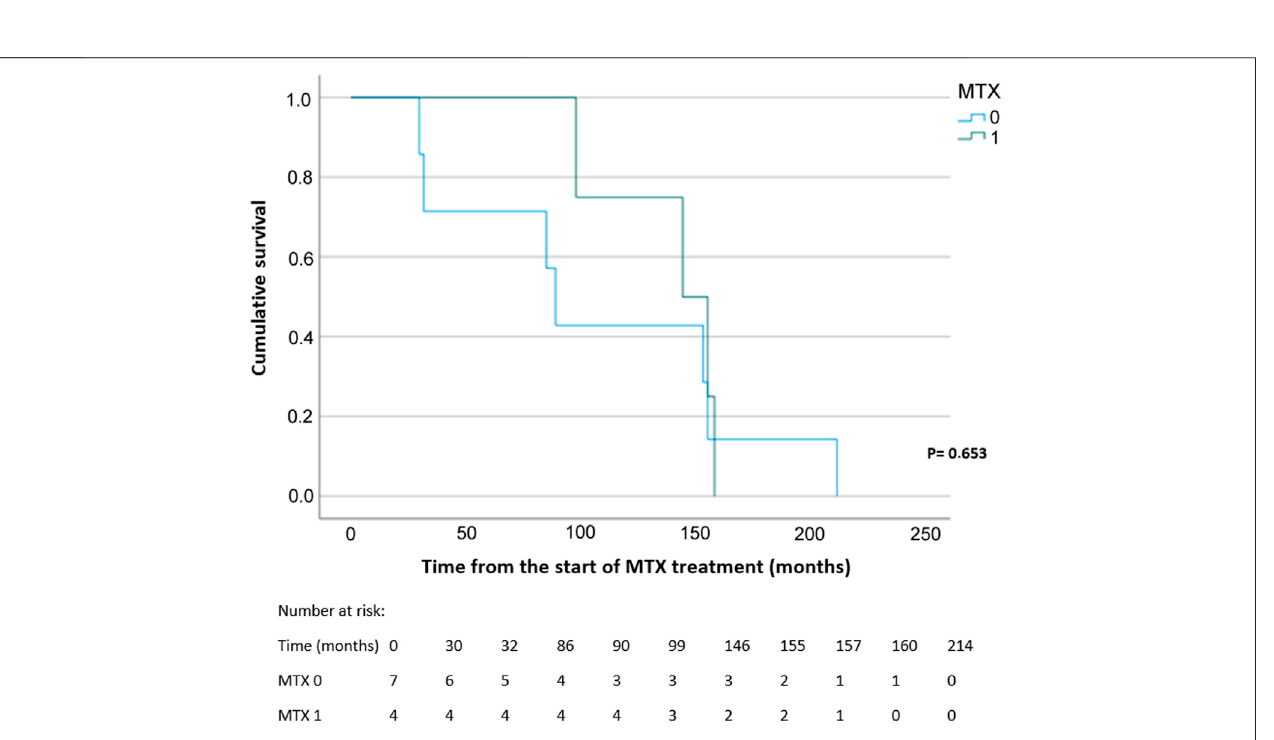
Frontiers in Pharmacology |